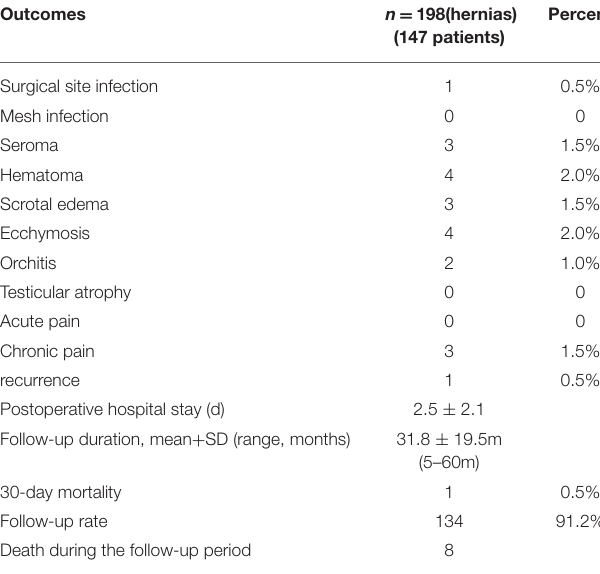
TABLE 3 | Postoperative